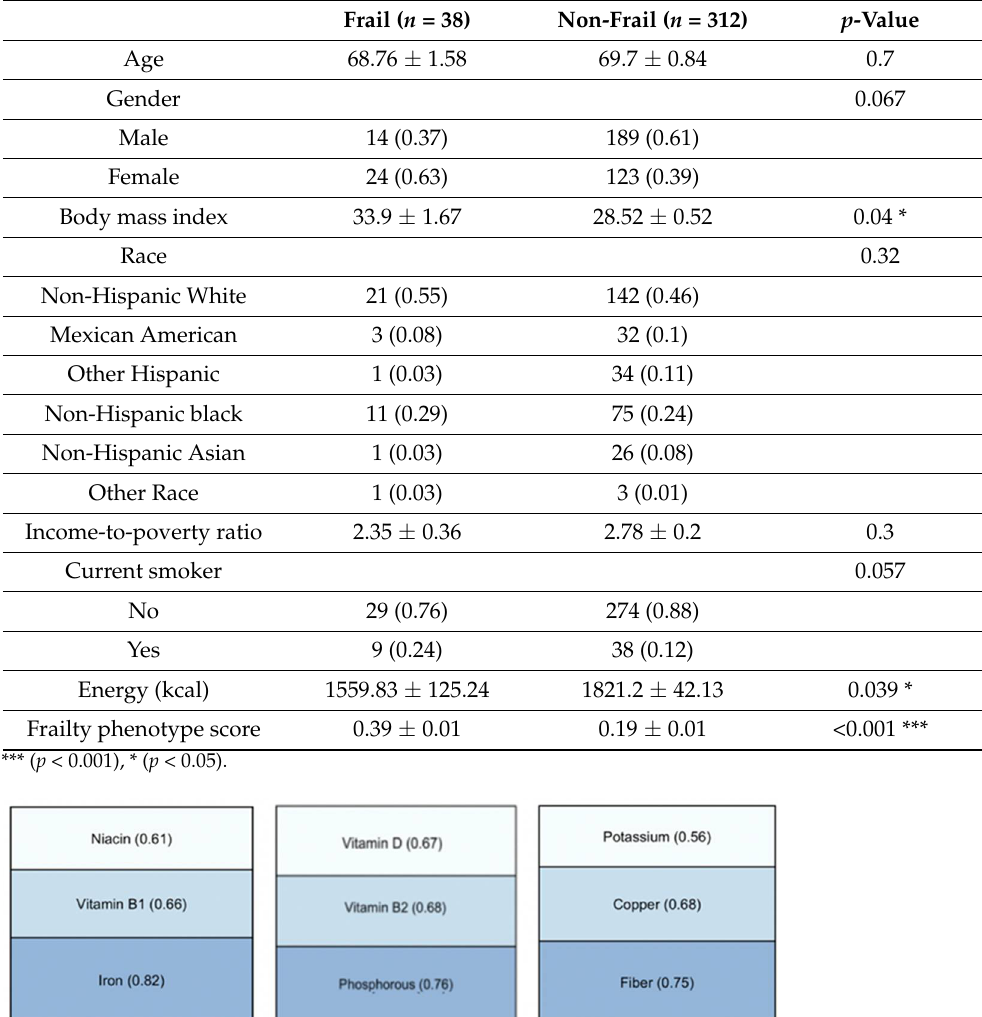
Table 2. Demographics of frail and non-frail older adults with olfactory dysfunction—physical frailty.